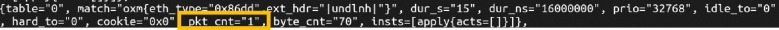
Snapshot of the switch showing that Flow-Entry-3 matches one packet.